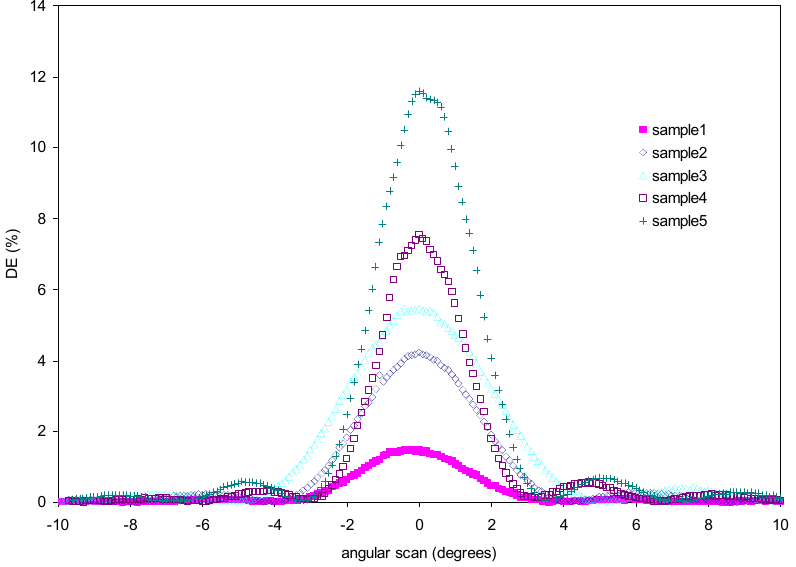
8 of 13 Figure 4. DEmax + TEmax versus DEmax for different exposure times during the hologram record- ing.